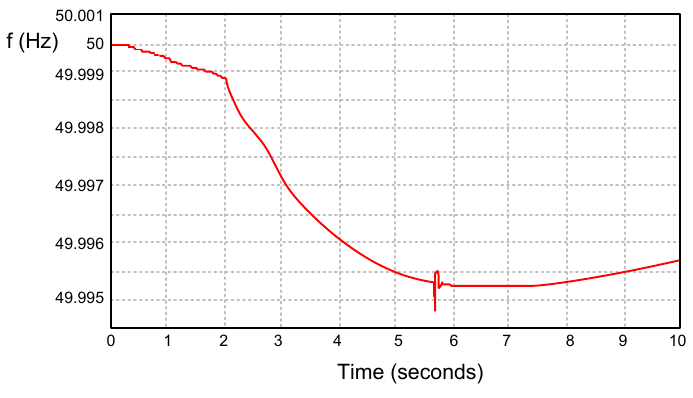
Figure 10. Frequency variation in 400 kV RCONST1 bus.